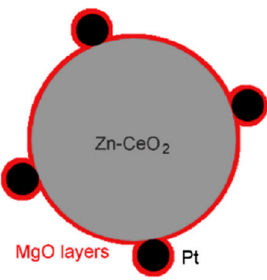
Figure 23. Illustration of the photocatalyst used by Pan et al. Copyright (2020), reprinted from [46] with permission from Elsevier.